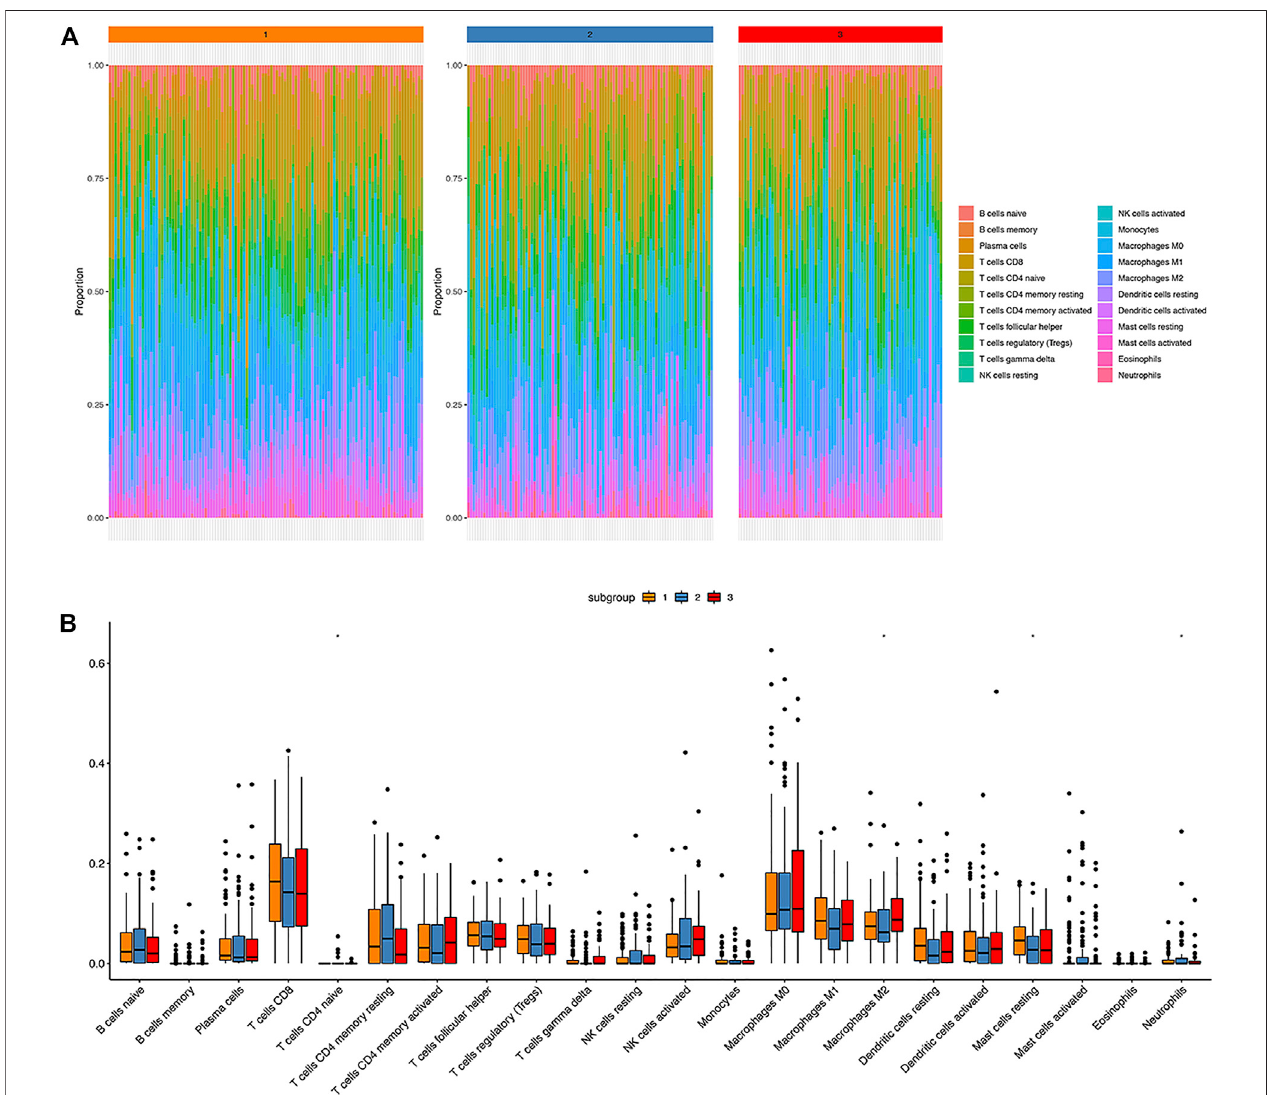
FIGURE5 | Immune landscape atlas in three HPV clusters. (A) : The distribution of22 types ofimmunecells inthree classi fi ed clusters; (B) :Percentage distribution of immune cells in three classi fi ed clusters; ns: p > 0.05, *: p ≤ 0.05, **: p ≤ 0.01, ***: p ≤ 0.001, ****: p ≤ 0.0001.